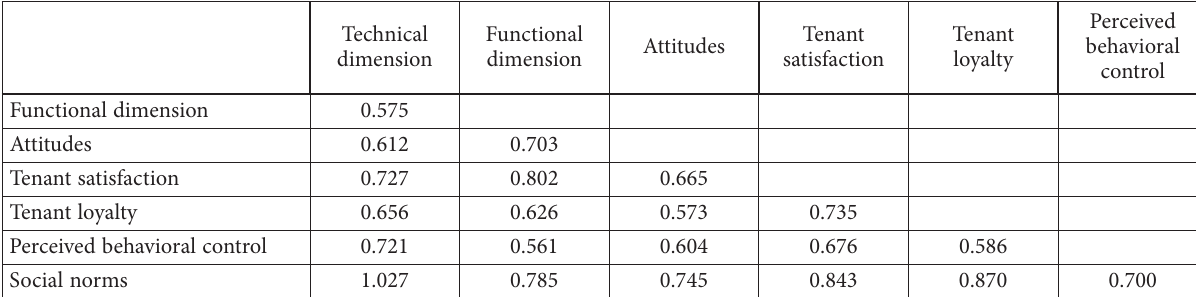
Table 4. HTMT value of latent